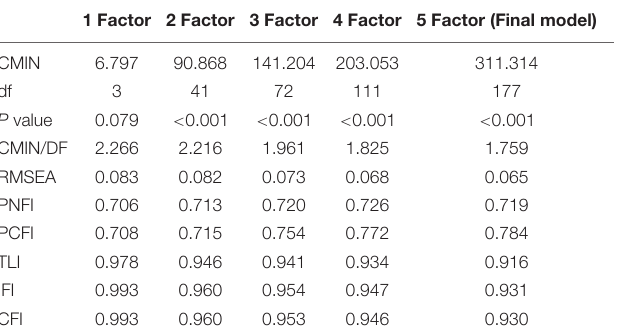
TABLE 3 | Factors adjustment indexes obtained in exploratory factor analysis of the FCHS ( n = 225).